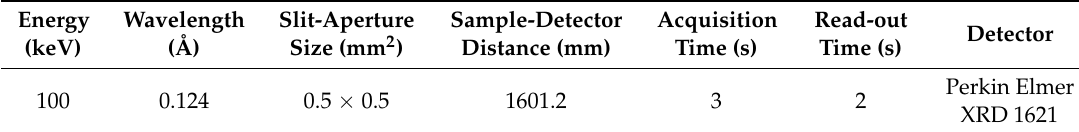
Table 2. Experimental parameters used during the high-energy synchrotron X-ray diffraction (HEXRD)